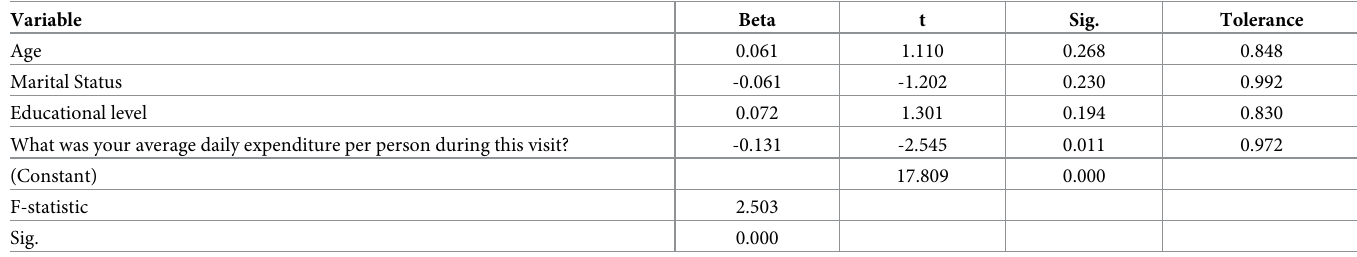
Table 4. Socio-demographic variables and